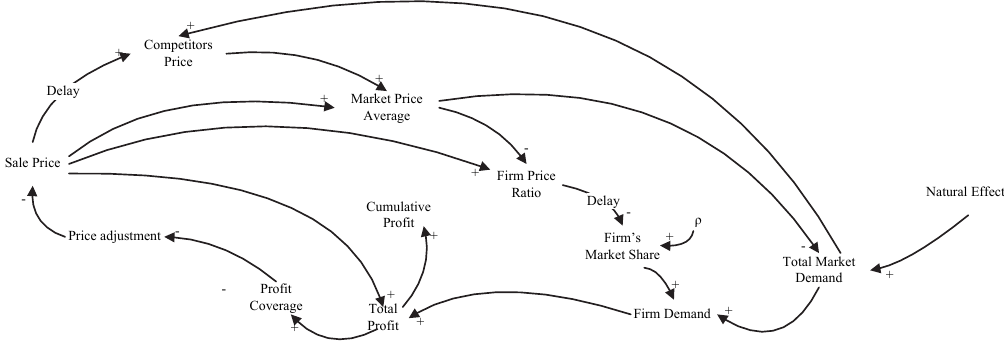
Fig. 3. The cause and effects of price on market share in an oligopoly market